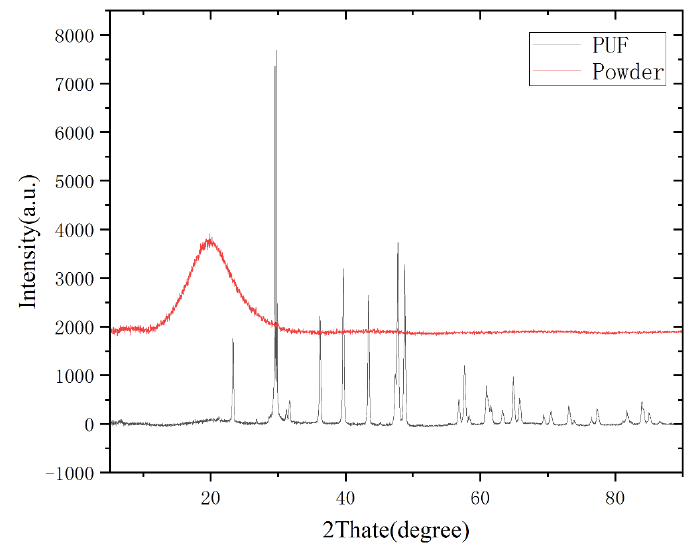
Figure 6. XRD curves before and after crushing.